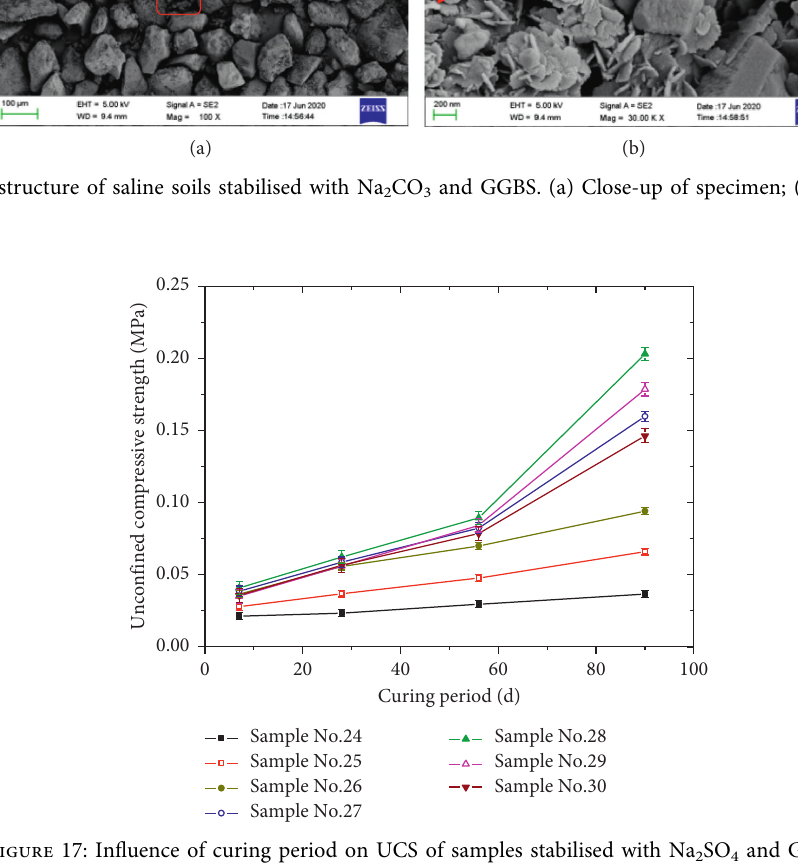
2 SO 4 and GGBS.